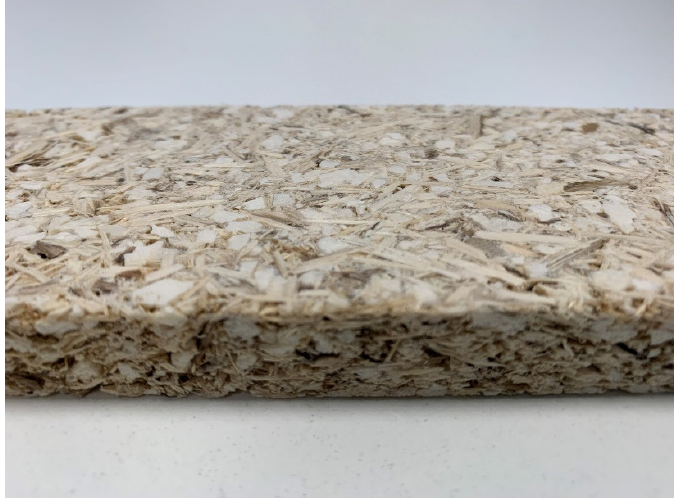
Figure 14. Cardoon particleboard with potato starch binder. Panel thickness is 16 mm.